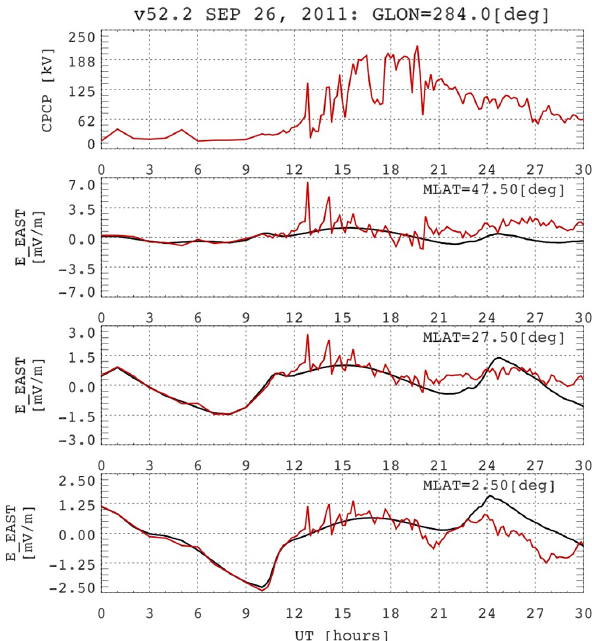
Figure 8. The universal time variation of the cross-polar cap po- tential (CPCP) (kV) used to drive the coupled model simulation (top panel), the corresponding response of the eastward electric field at 90km at three magnetic latitudes: 2.5 ◦ , 27.5 ◦ , and 47.5 ◦ are shown for the American longitude sector, at 284 ◦ E geographic longitude. The red lines show the storm-time response, whereas the black curves are the quiet-time reference simulation in which the CPCP value is kept constant at 25kV for the entire simulation pe- riod. The x axis starts at 00:00UT on 26 September,